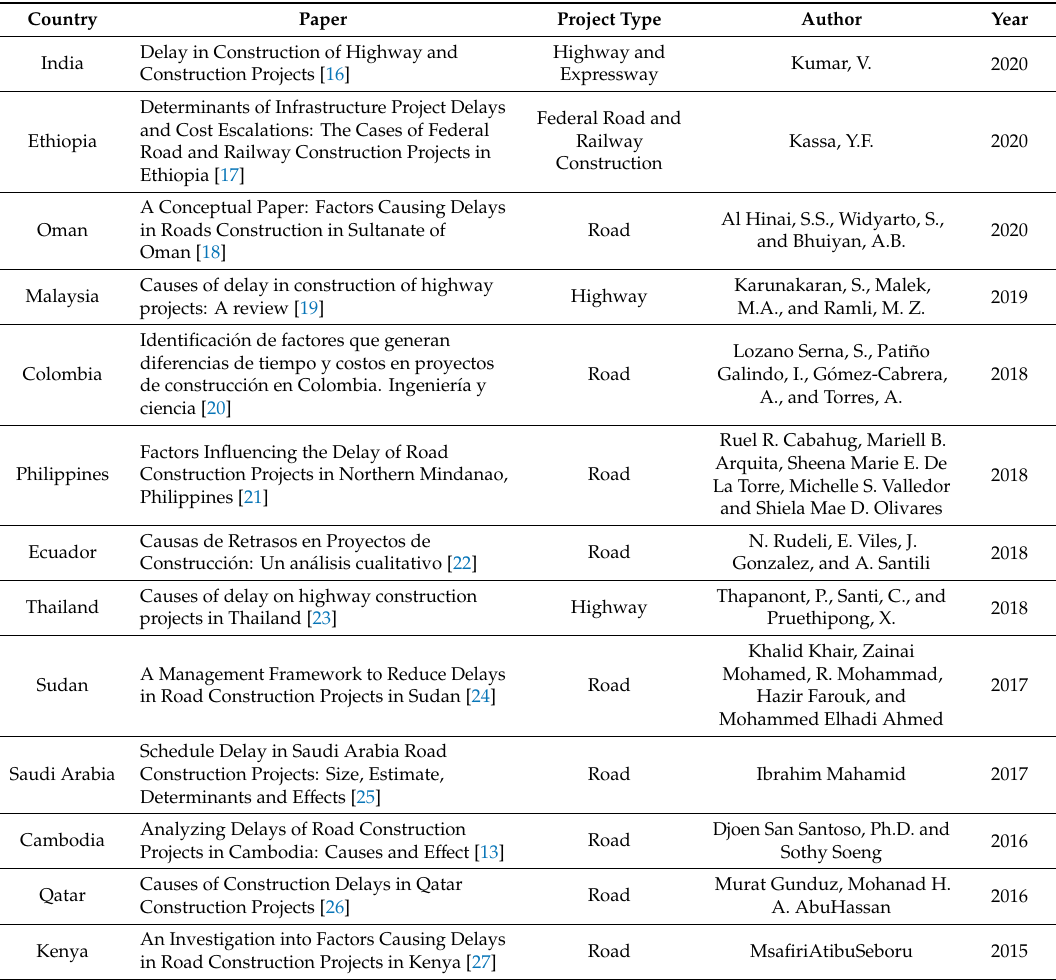
Table 1. Literature used for a data